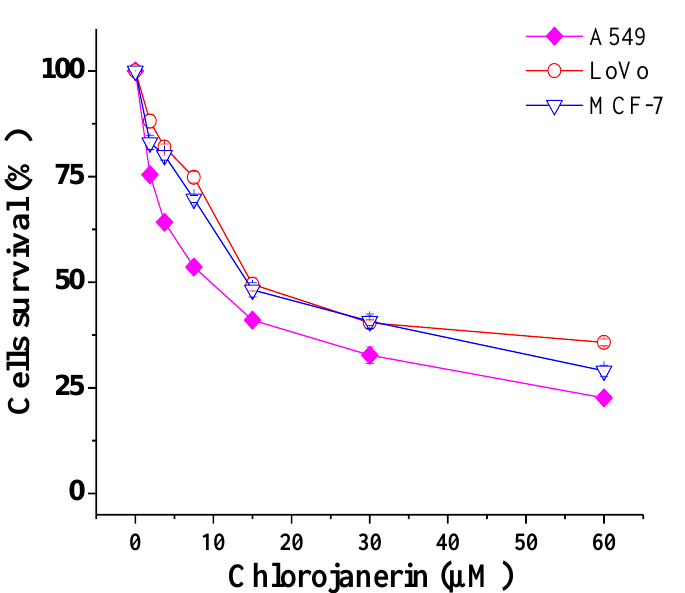
Figure 1. Cytotoxic effects of chlorojanerin on the viability of different human cancer cells measured by MTT assay. Cells were treated with various chlorojanerin concentrations (0 – 60 µM) for 24 h. Results are the mean ± S.D. from three separate experiments. Table 1. IC 50 values of chlorojanerin and standard doxorubicin for different cancer cells. Compound